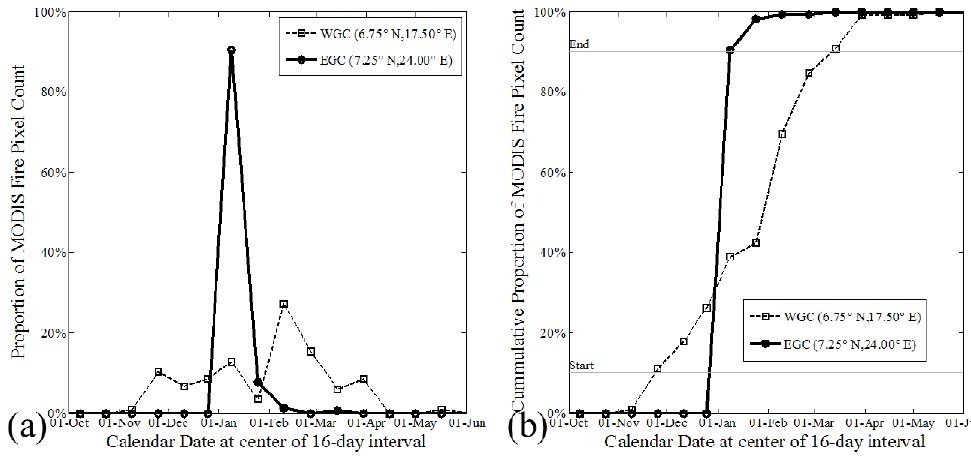
Figure 2. Normalized seasonal profiles of ( a ) MODIS active fire (AF) pixel counts and ( b ) cumulative distributions of MODIS AF pixel counts for two 0.05° grid cells at 16-day temporal resolution. Seasonal profiles are generated from 10 years of aggregated observations, and the locations of the example grid cells, referred to as the western and eastern grid cells (WGC and EGC), are shown in Figure 1. The 10th and 90th percentiles of the cumulative AF pixel counts are shown in (b) to demonstrate the “fire season duration” as determined in this